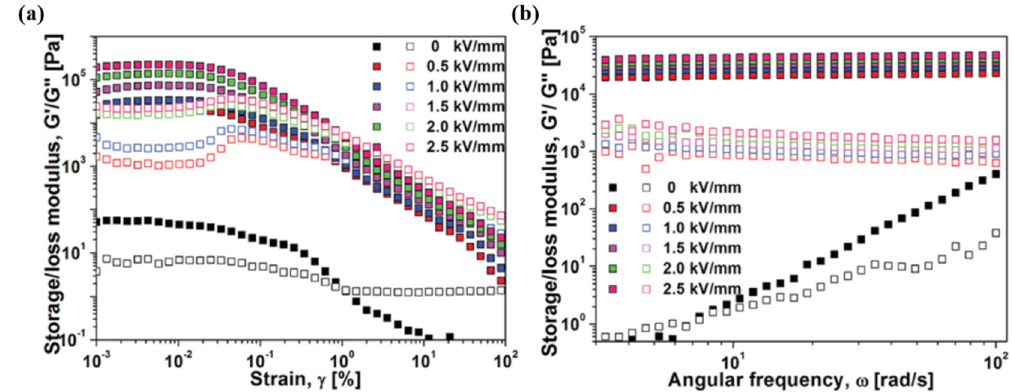
Figure 13. ( a ) Strain amplitude sweep test and ( b ) angular frequency sweep test for Fe 3 O 4 / GO-based ER fluid (15 wt.%) [55].